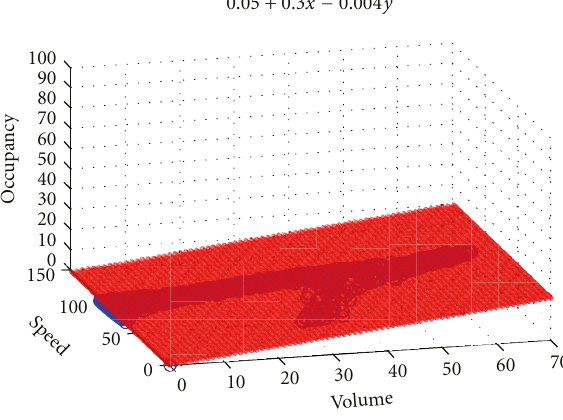
Figure 8: Regression plane for Flow tra ffi